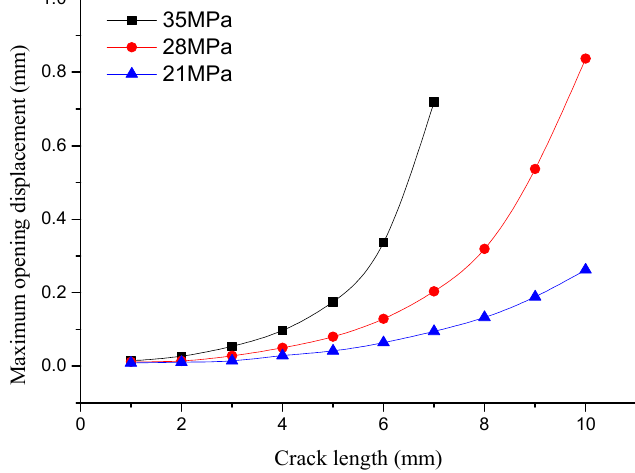
Figure 11. Relationship of the maximum opening displacement and the initial crack length under different internal pressures.